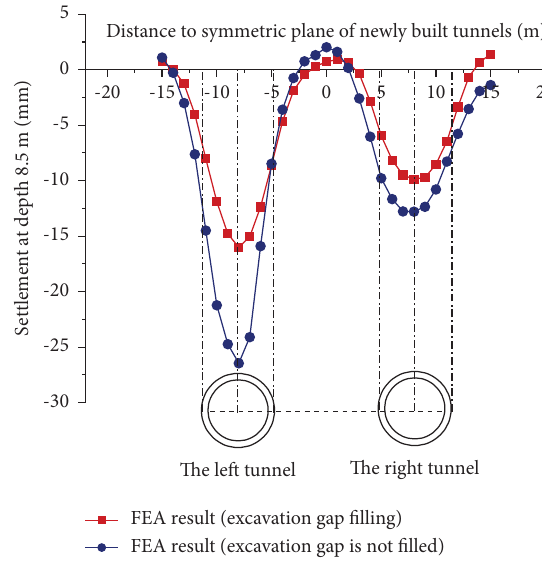
Figure 17: 8.5m depth simulation results.